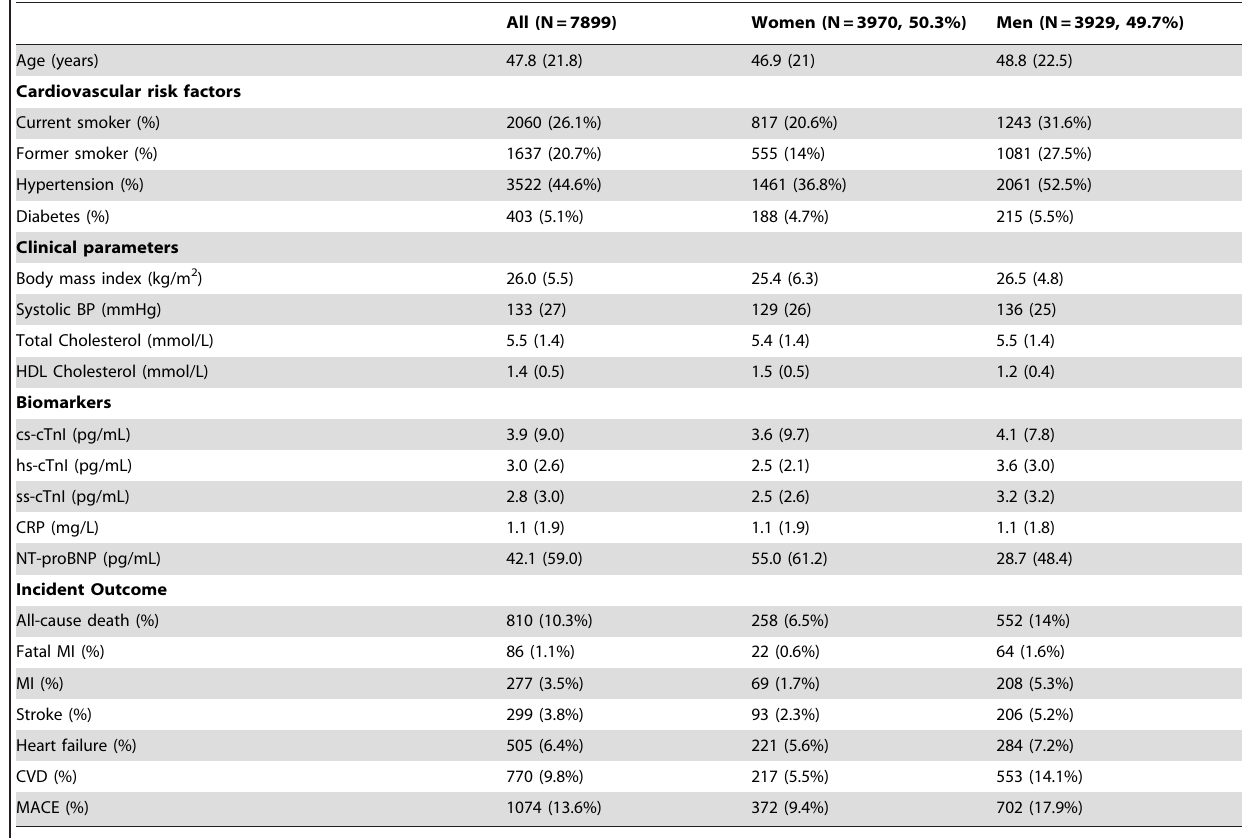
Table 1. Baseline Characteristics of the Study Population by Gender.